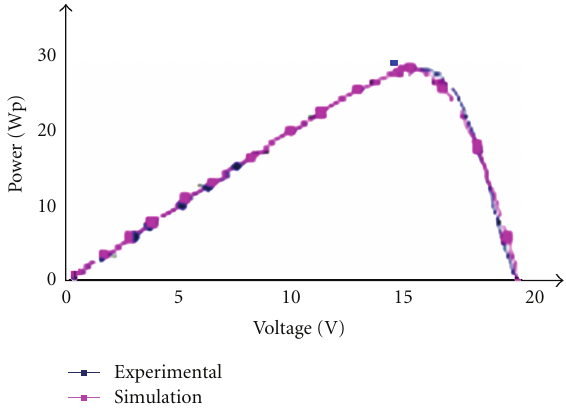
Figure 11: Simulation and experimental P-V